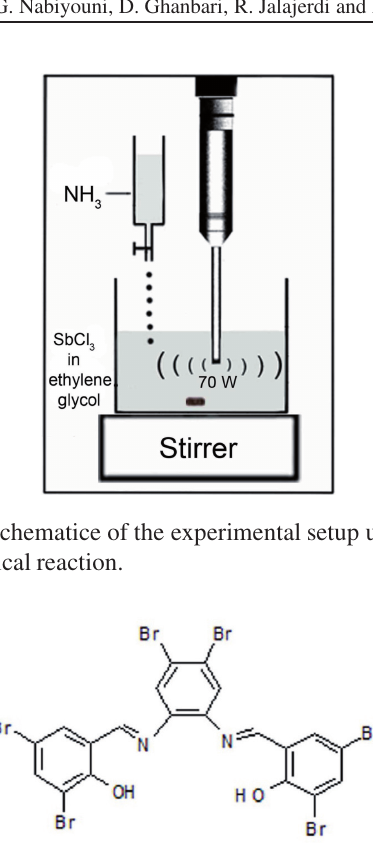
Figure 2. Brominated